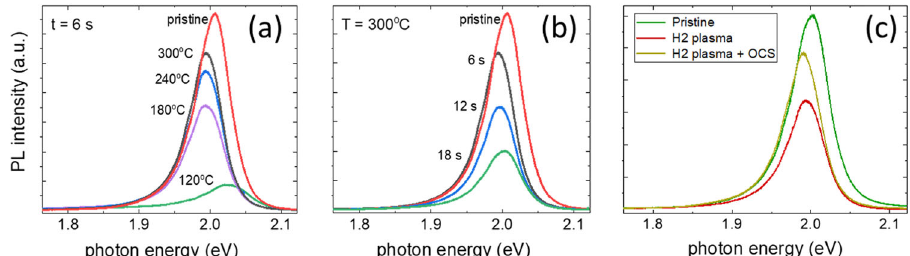
Fig. 2 Impact of DPS H 2 treatments on as-grown WS 2 on Si/SiO 2 . a PL emission spectra of WS 2 after a 6 s downstream plasma strip performed at different substrate temperatures; b PL emission spectra of WS 2 exposed to the downstream plasma at 300 ∘ C during 6, 12, and 18 s; c combined effects of DPS H 2 (12 s at 300 ∘ C) followed by OCS soak (240 s at 60 ∘